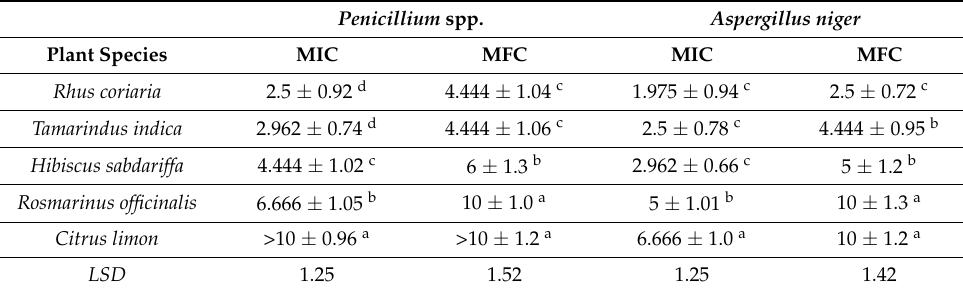
Table 5. The minimum inhibitory concentration (MIC) and minimum fungicidal concentration (MFC) of methanolic extracts